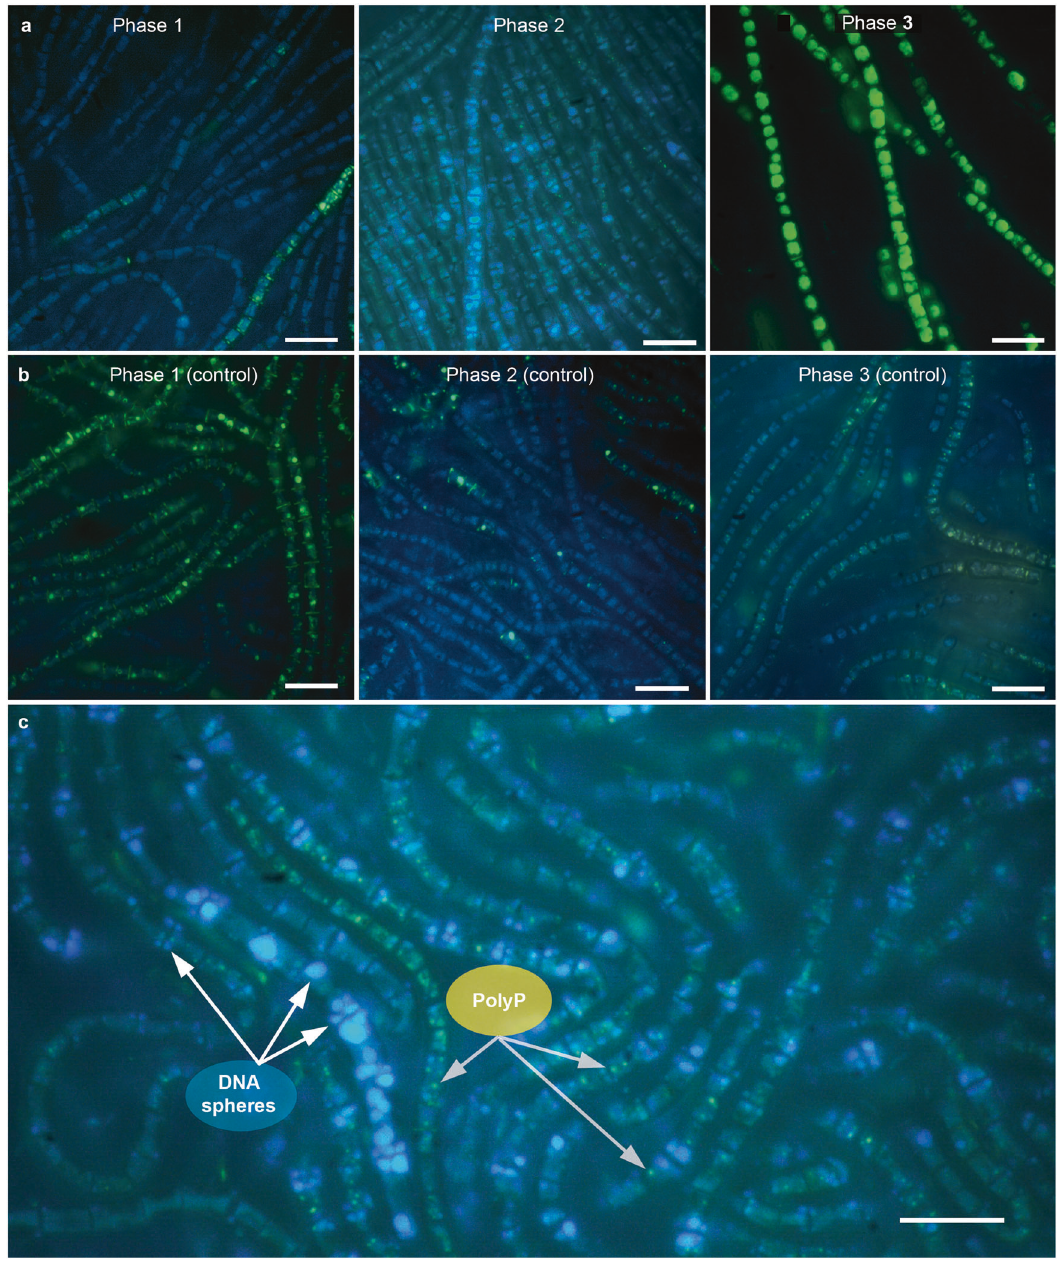
Fig. 4 Examples of qualitative microscopic observations at different bio fi lm development phases. DAPI-polyphosphate (polyP) fl uoresces in a yellow-green colour, DAPI-DNA fl uoresces in a blue colour. a Phases of the low P experiment. Phase 1: Heterogeneous polyP accumulation in individual fi laments, Phase 2: DNA accumulation into globular spheres and heterogeneous polyP accumulation at the end of Phase 2, Phase 3: Homogeneous polyP accumulation in all cells, being of noticeable size ( b ) Phases of the high P experiment. Phase 1: Homogeneous polyP accumulation in all cells, Phase 2 – 3: Heterogeneous polyP accumulation in individual cells, ( c ) Close up of Phase 2 of the low P experiment showing DNA spheres preferentially accumulating at the cell ’ s polar membranes and adjacent to polyP. White bar indicates a scale of 10